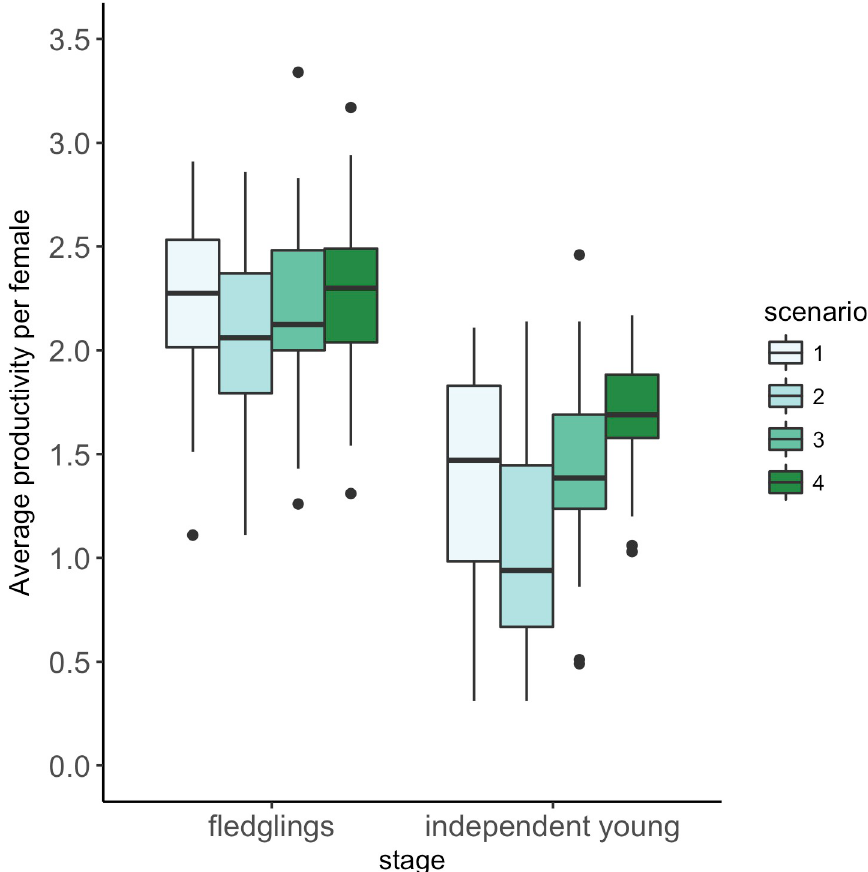
Fig 2. Model estimated annual productivity of female yellow warblers under four reservoir water management scenarios. Boxplots show estimates for 50 breeding seasons. Scenario 1 = long term conditions (ie the reservoir water levels observed between 1968 and 2017; Scenario 2 = early fill years (when water levels reach 435m a.s.l. by June 12); Scenario 3 = late fill years (when water levels do not reach 435m a.s.l. until after June 12); Scenario 4 = zero flooding (where reservoir water levels never exceed 435 m a.s.l). Boxes show the lower quartile, the median and the upper quartile. The whiskers extend to the smallest/largest value or 1.5 times the interquartile range, with the points showing outliers that extend beyond 1.5 times the interquartile